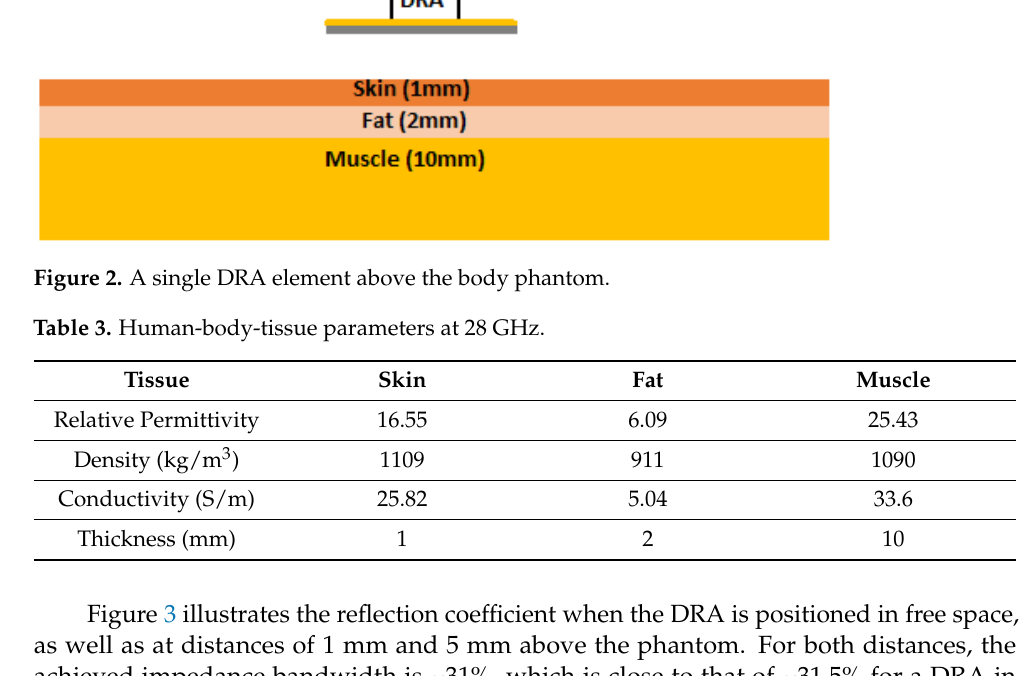
Table 3. Human-body-tissue parameters at 28 GHz.